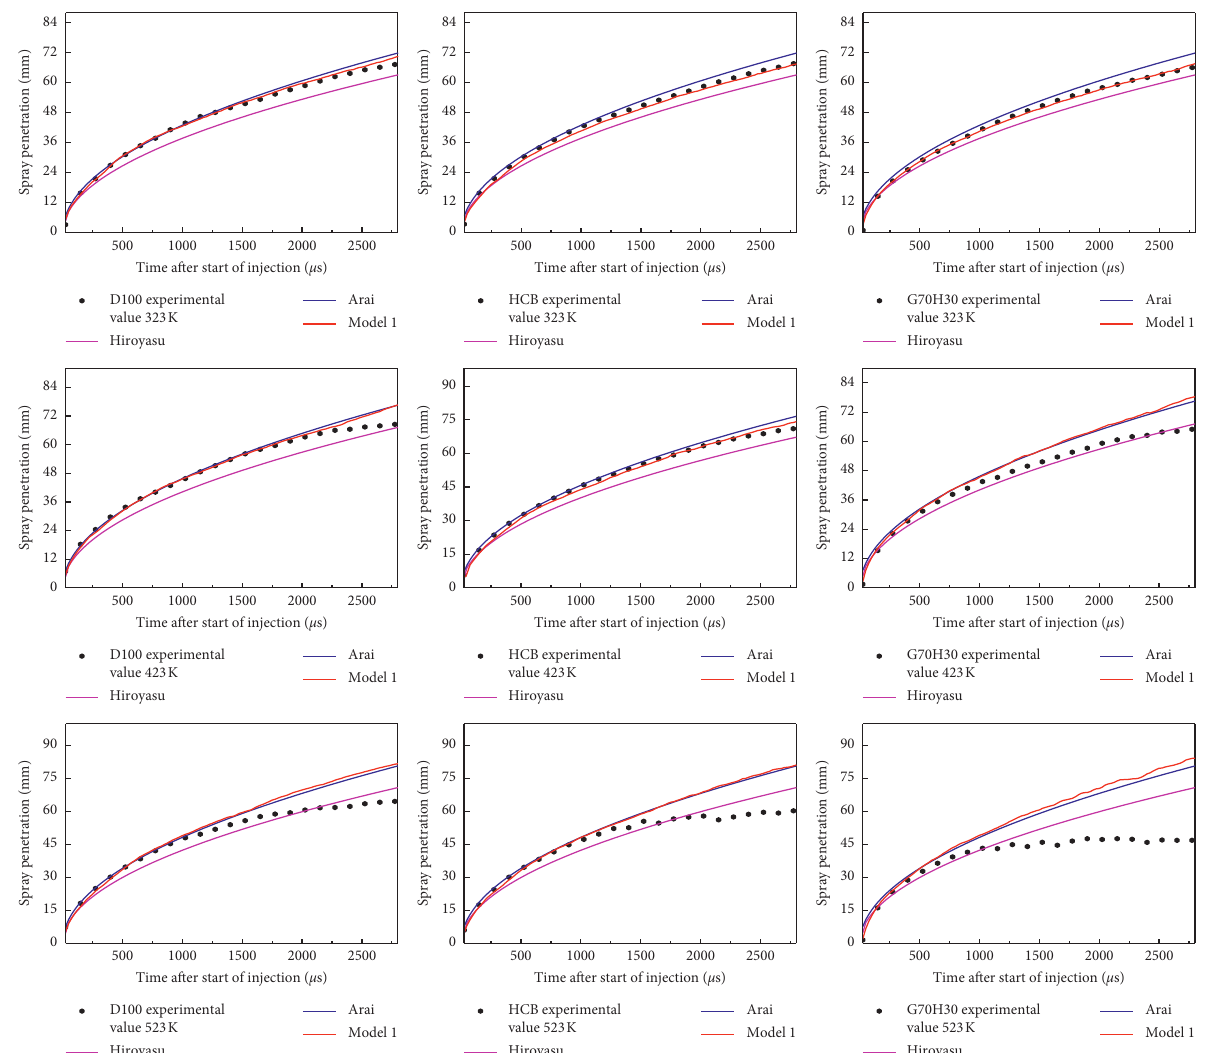
Figure 5: Comparison between experimental spray data and models for D100, HCB, and